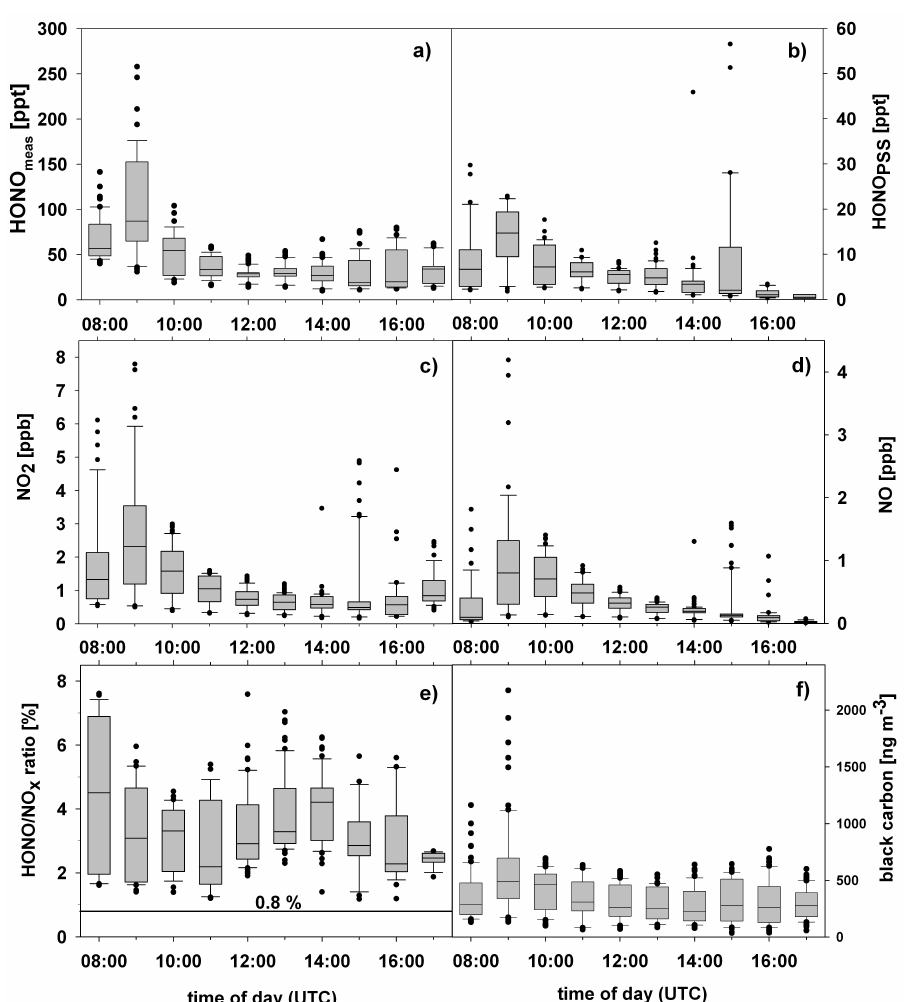
Fig. 2. Daytime cycles of (a) measured HONO mixing ratios, HONO meas (b) calculated HONO mixing according to Eq. (1), HONO PSS (c) NO 2 and (d) NO mixing ratios as well as (e) HONO/NO x ratios with the value of 0.8% for direct emissions (Kurtenbach et al., 2001) marked as black line and black carbon concentration (f) . The boxes and whiskers represent a one hour time interval (centred in the middle) of five minute data (22–72 data points) of 7 cloud free days (21 ,22, 23, 25, 26, 27 November and 2 December). The upper ends of the boxes represent the 75th percentile, the lower bounds the 25th percentile and the line within the boxes the median. The upper whisker marks the last point within the 90th percentile and the lower whisker that of the 10th percentile. Data points outside the 10th and 90th percentile are marked individually as